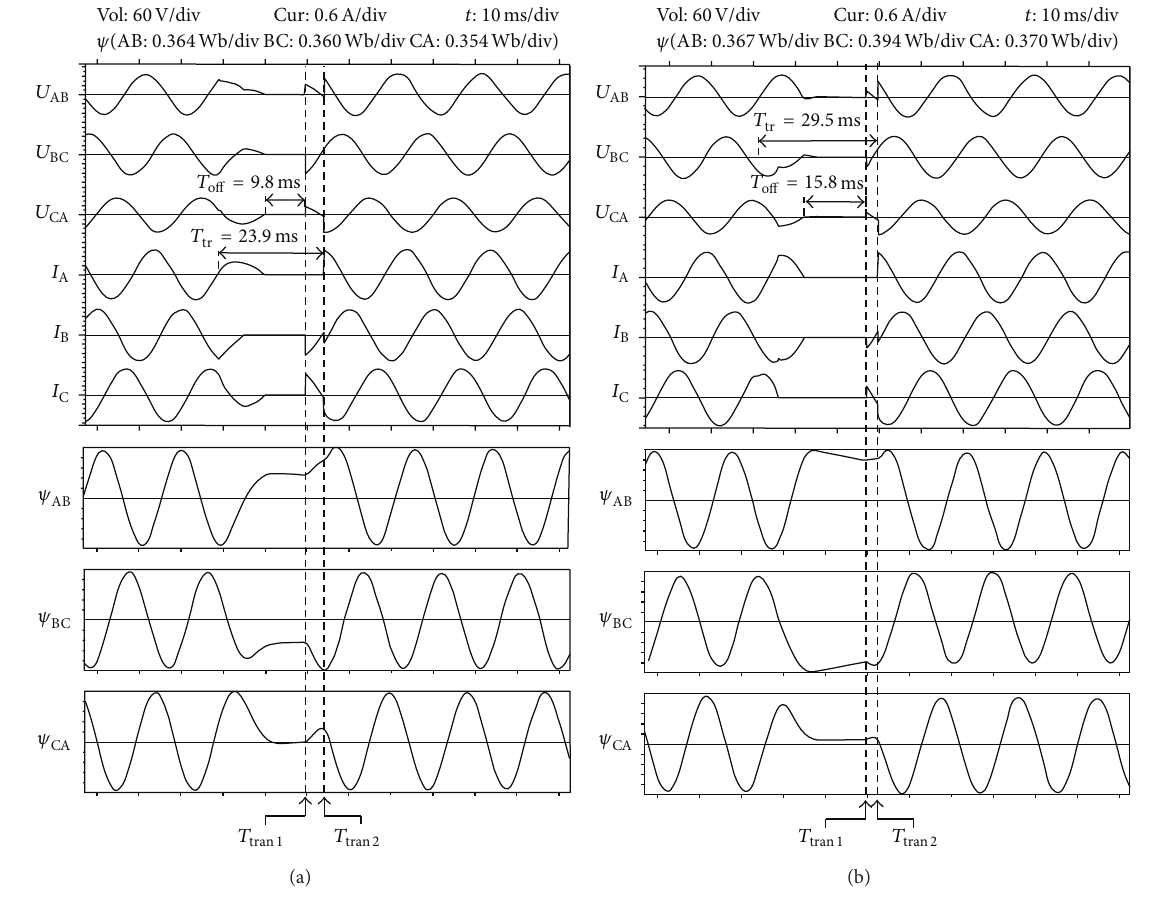
Figure 16: Waves of the transfer strategy with flux linkage DC component elimination. (a) Three-phase sag fault. (b) A phase line-open fault. From the top to bottom, they are AB, BC, and CA phase transformer voltage, A, B, and C phase load current, and AB, BC, and CA phase transformer flux